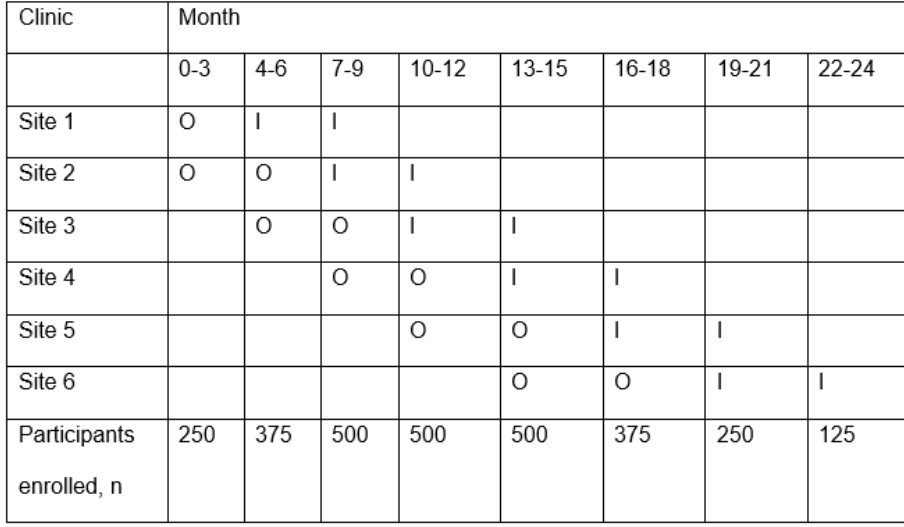
Figure 2. Stepped-wedge design at 6 sites. I: intervention; O: